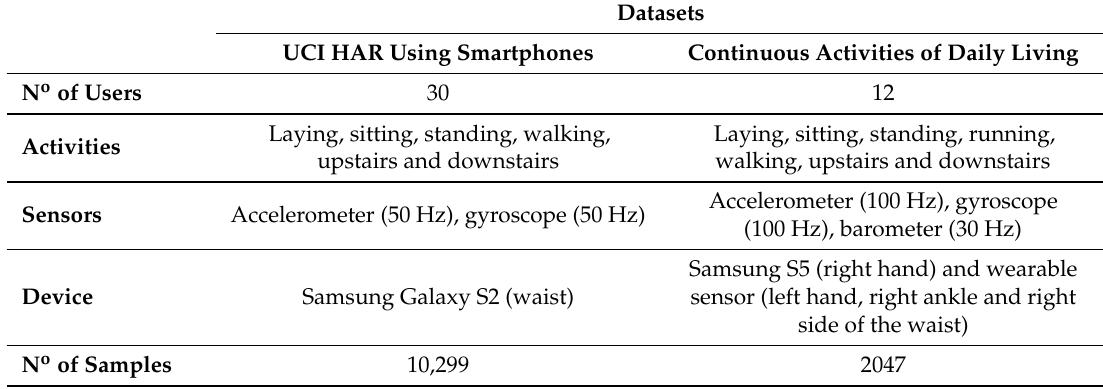
Table 1. University of California Irvine (UCI) dataset and Continuous Activities of Daily Living (CADL) dataset information on: number of users, activities performed, sensors, acquisition device, its position and dataset